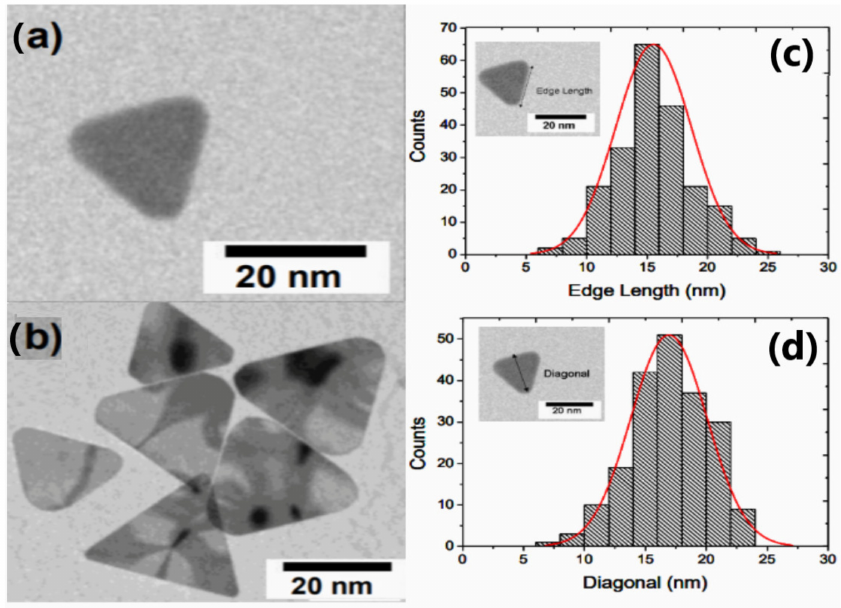
Figure 2. TEM images of ( a ) single TSNP, ( b ) multiple TSNP, ( c ) Edge length and ( d ) diagonal size distribution of